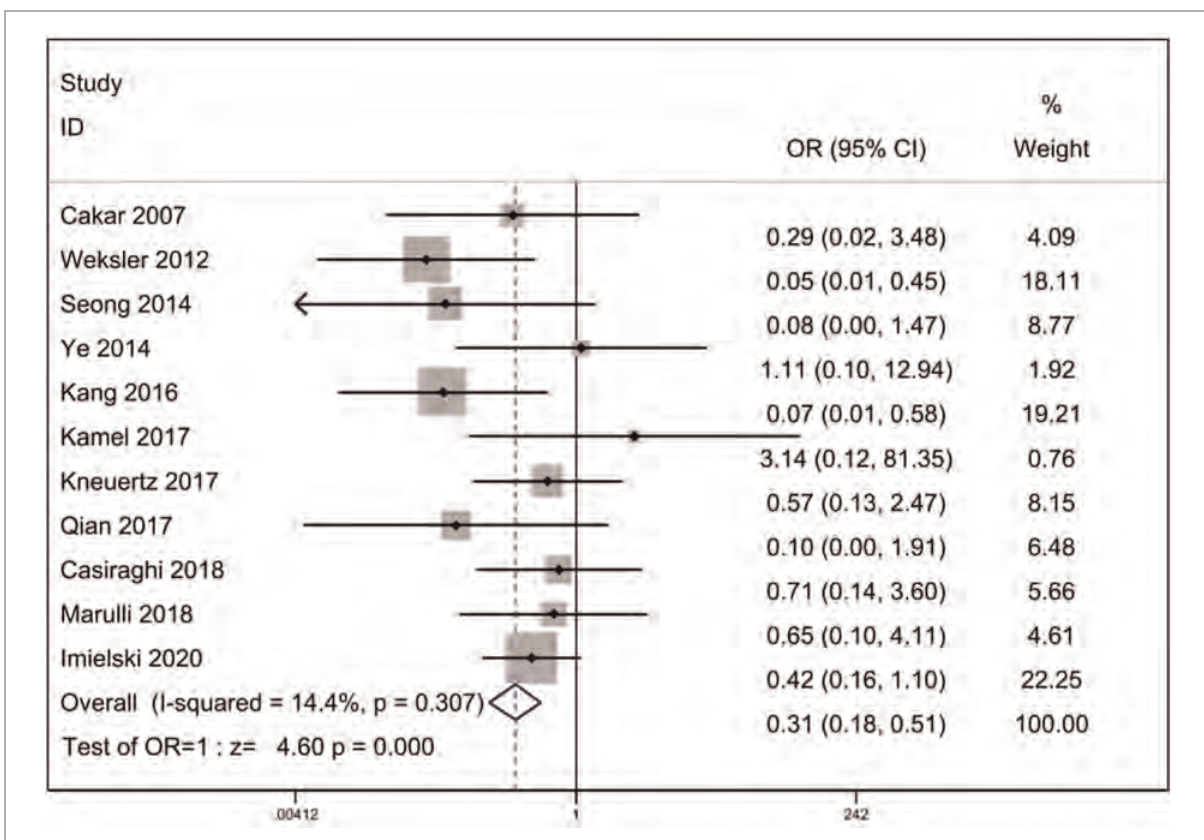
FIGURE 6 Comparison of operative complications between RATS and ST. OR, odds ratio; CI, con fi dence interval; RATS, robot-assisted thoracoscopic surgery; ST,